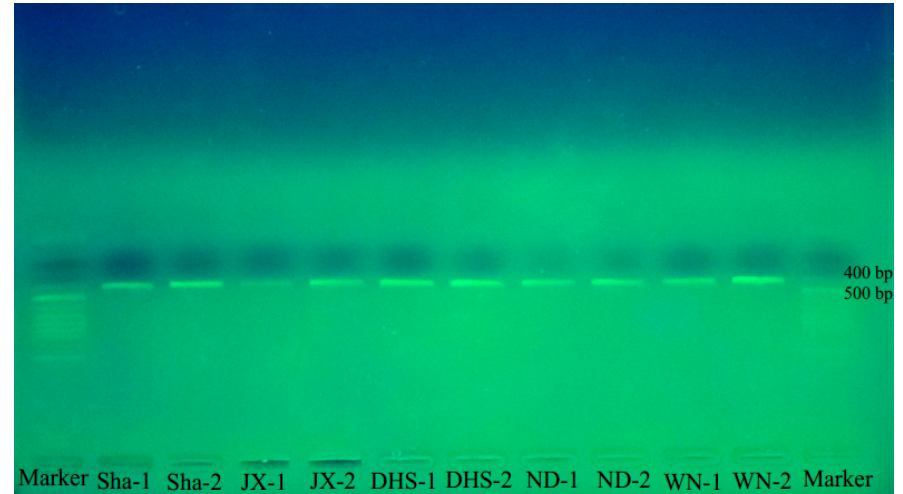
Figure 3. The BAR-RPA assays for identification of Wuzhimaotao in market samples. Lane Marker: 50 bp DNA Ladder. Lanes 2–11: 10 crude drug samples of Wuzhimaotao from 5 medicinal material markets (Sha, JX, DHS, ND, and WN).